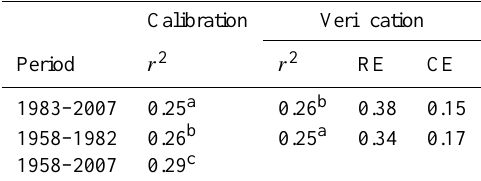
Fig. 3. Correlation values ( p < 0.05) between weighted-TRW in- dices and mean June–July CRU Palmer Drought Severity Index (scPDSI), calculated in KNMI explorer (van Oldenborgh, 1999).